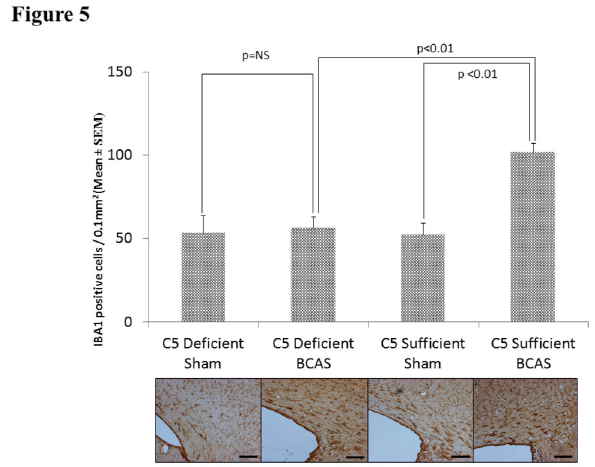
Figure 5. Reactive Microglia: IBA-1 staining for reactive microglia in the medial corpus callosum in C5 sufficient and C5 deficient mice subjected to sham and BCAS operations. Above: IBA-1 positive cell counts in each experimental group. Below: Representative coronal sections of the right corpus callosum with high magnification insert (medial corpus callosum). Bars indicate 50µm. n=10 C5D/ BCAS, n=10 C5D/ sham, n=9 C5S/ BCAS, n=9 C5S/ sham.